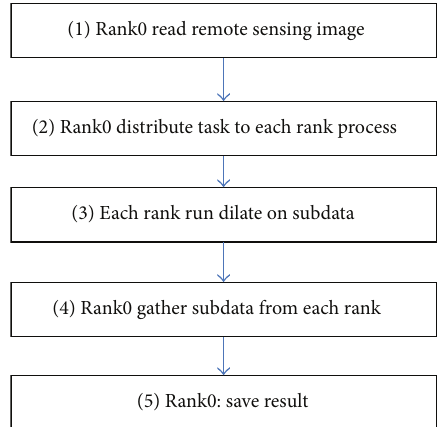
Figure 1: Five stages of